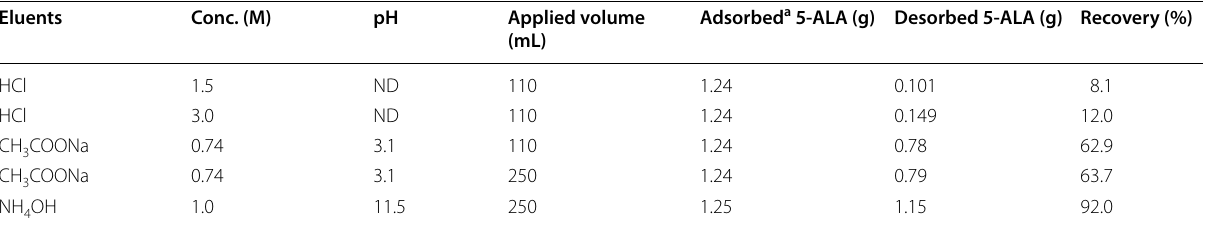
a All the chromatography is injected by 300 mL 5-ALA at 4.16 g/L for each batch. ND means not determined